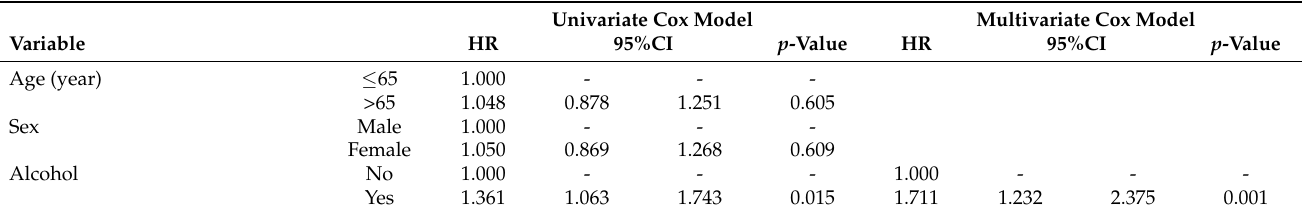
Table 2. Risk factors for hepatocellular carcinoma (HCC) recurrence according to univariate and multivariate